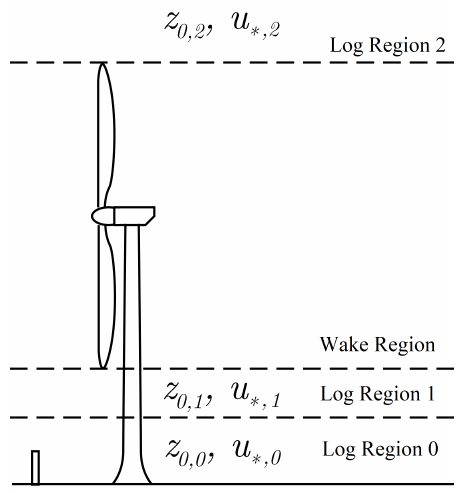
Figure 2. The several flow regions with their respective aerodynamic